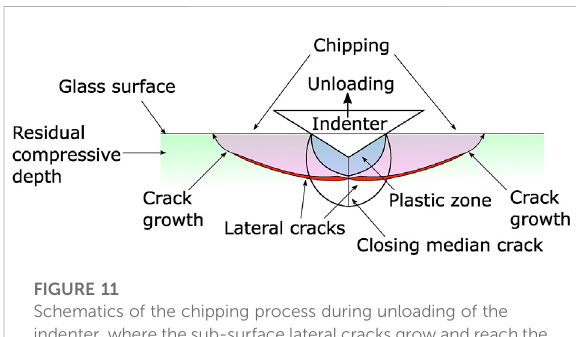
FIGURE 11 Schematics of the chipping process during unloading of the indenter, where the sub-surface lateral cracks grow and reach the